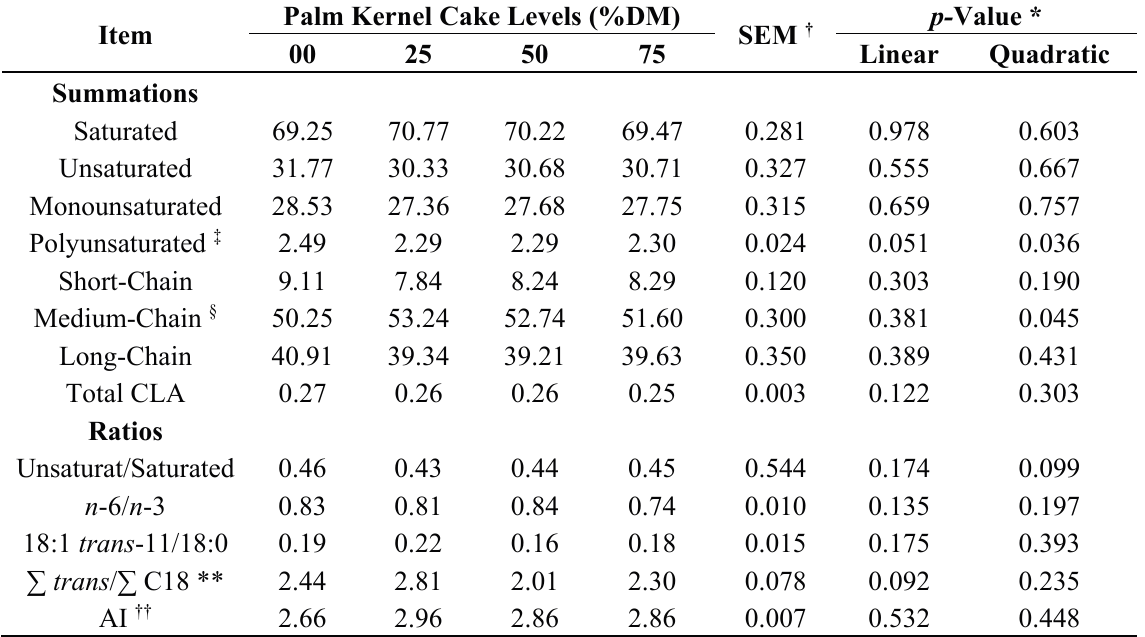
Table 5. The profile of grouped fatty acids (%) of fat from fresh cheese that was produced with milk from pastured cows receiving supplements with palm kernel